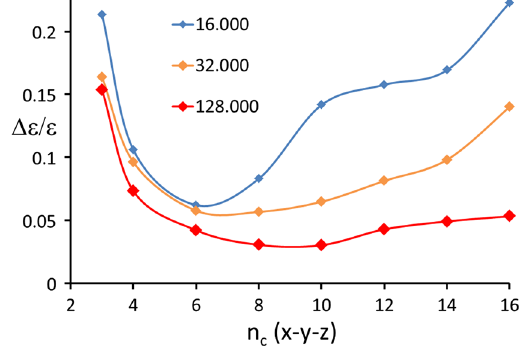
FIG. 11. Relative growth of ϵ 6 d in FODO for N ¼ 16 . 000 = 32 . 000 = 128 . 000 , as function of the number of grid cells in x; y; z